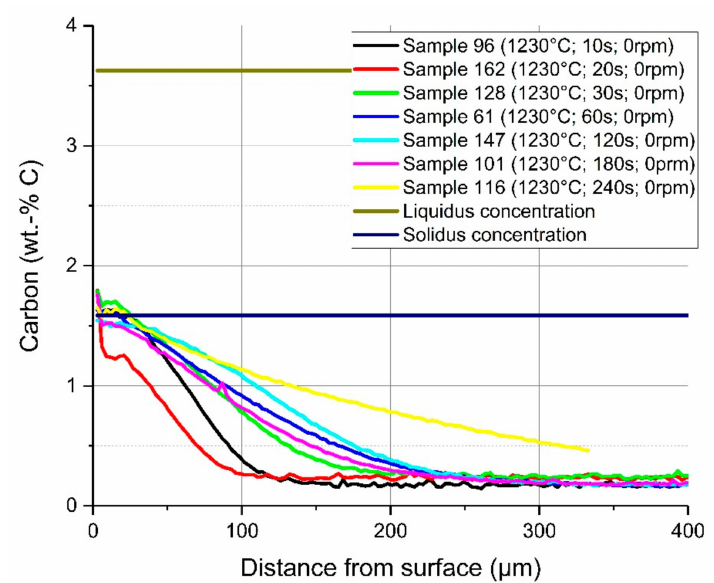
Figure 11. Average carbon composition and di ff usion depth from the detected solid–liquid interface under natural convection in the melt at 1230 ◦ C equilibrium temperature.